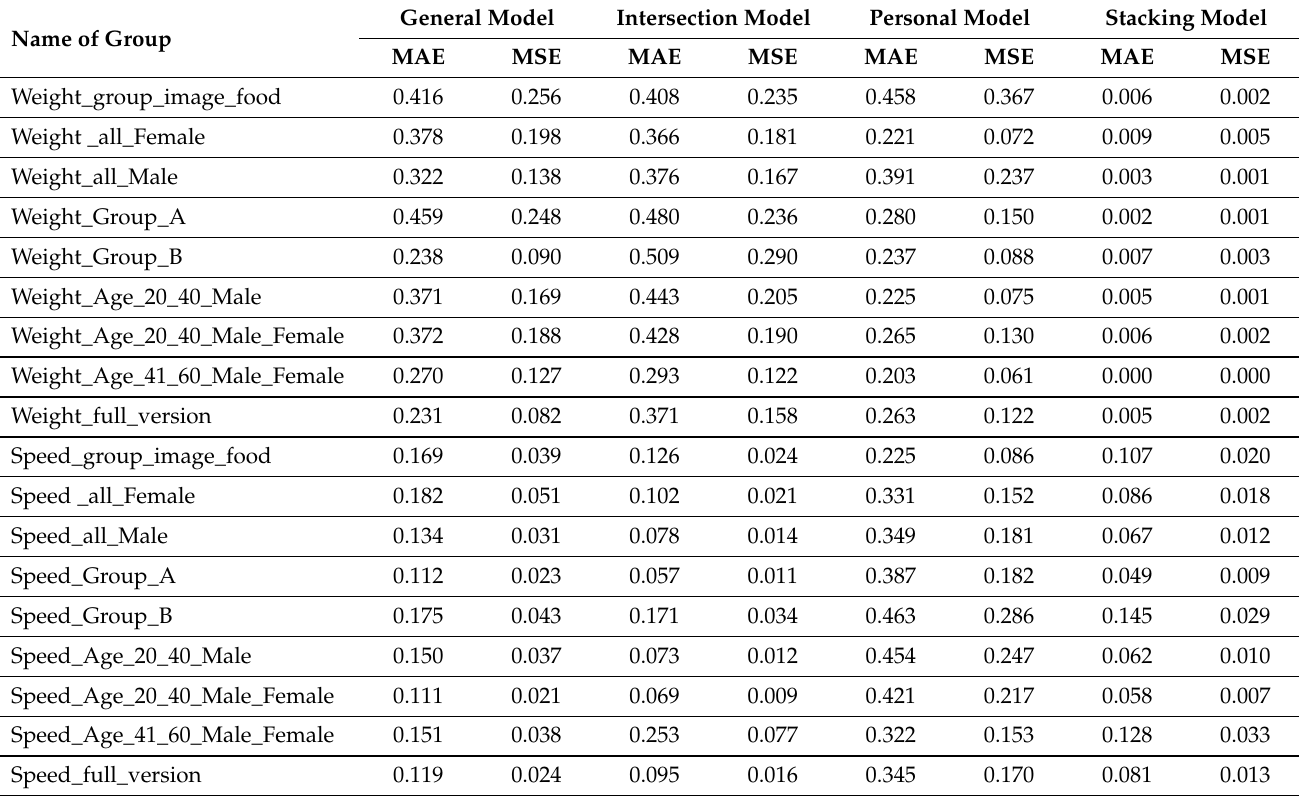
Table 4. Evaluation results of the data-driven stacking-based model.